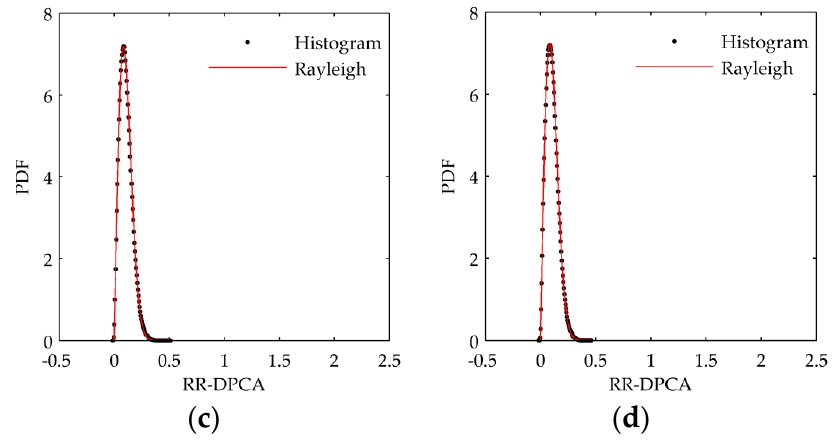
Figure 2. RR-DPCA histogram and its estimated PDF versus the size of window. ( a ) L = 1; ( b ) L = 3; ( c ) L = 5; ( d ) L = 7.